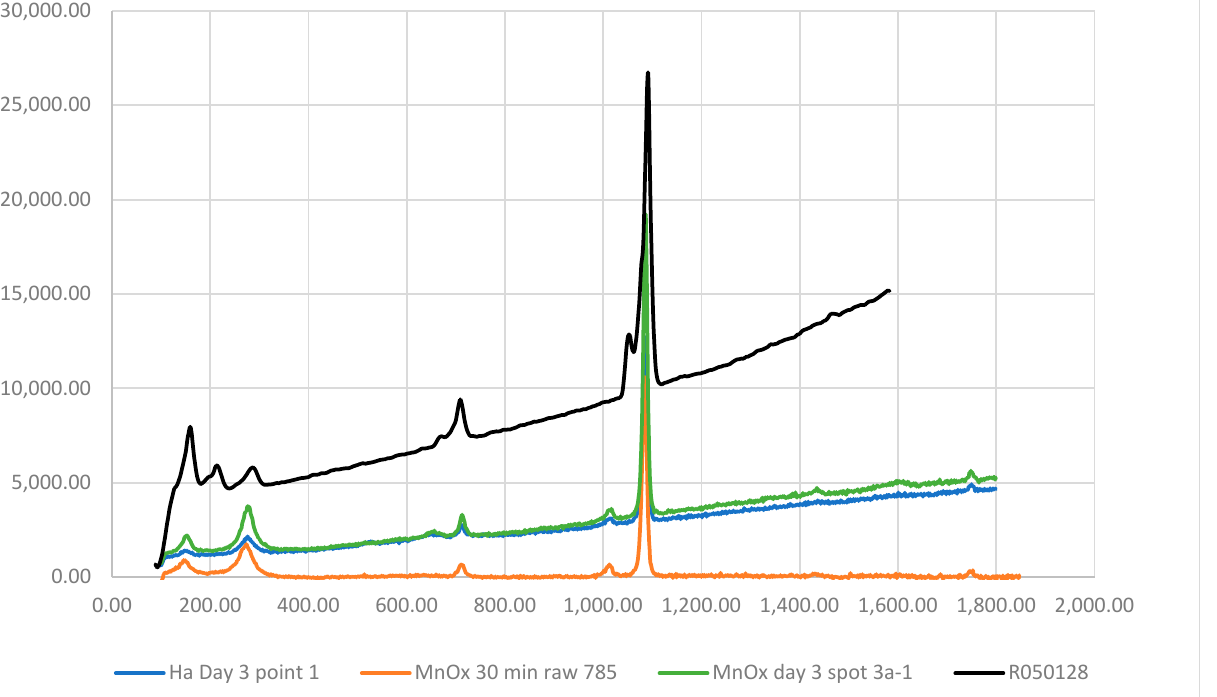
Figure 5. Sample R050128 (RRUFF, 2015) is a calcite, not a single crystal, with aragonite traces still present (black); HA Day 3 point 1 sample (blue) is a precipitate on the media pretreated with haloacetic acid where media is submerged in water for 3 days; MnOx 30 min raw 785 (orange) where media was not pretreated and was submerged for 30 min; sample MnOx 3 day spot 3a-1 media was not pretreated with anything and was submerged for 3 days